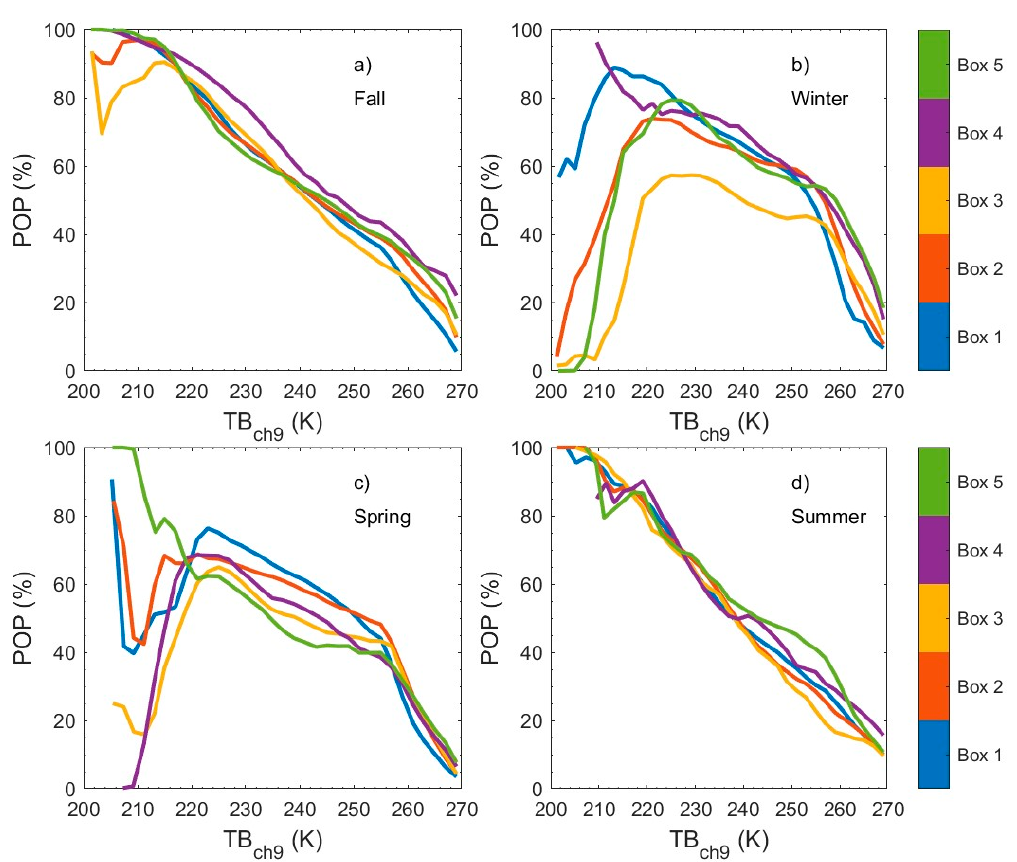
Figure 5. POP-TB 10.8 relationship obtained from the whole dataset (i.e., from 1 July, 2015 to 31 December, 2017) for each box for ( a ) fall, ( b ) winter, ( c ) spring, and ( d ) summer season, respectively.